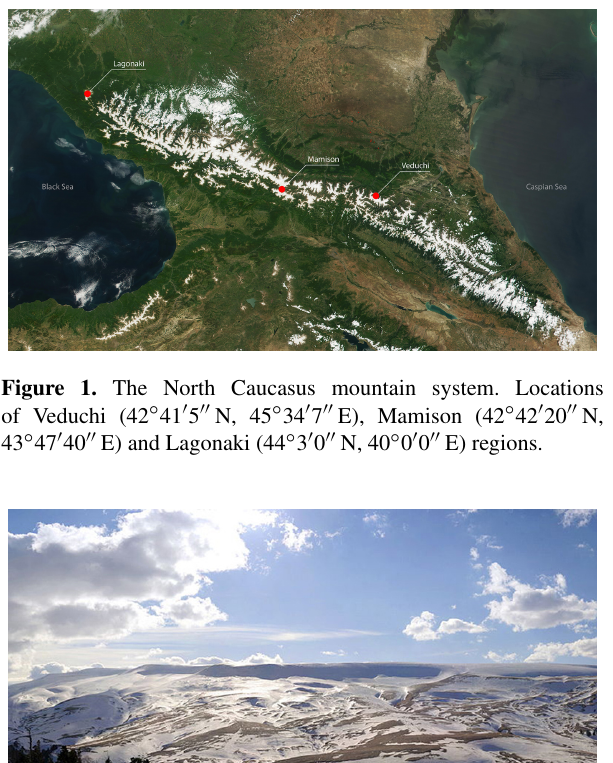
cipitation and snow accumulation in the eastern, central and western